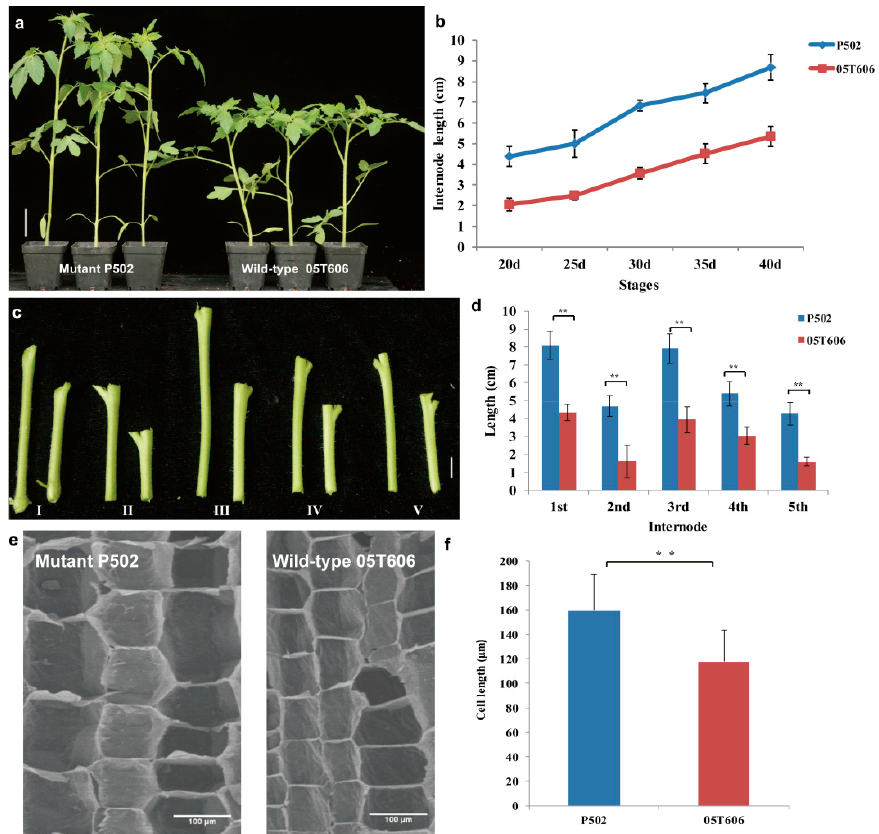
Figure 1. The phenotypic characterization of the mutant P502 and wild-type 05T606 at 40-day-old seedlings. Morphological phenotypes ( a ) and the statistical data of internode lengths ( b ) of the mutant P502 and wild-type 05T606. ( c ) Morphological phenotypes of the first five internode lengths of the mutant P502 (left) and wild-type (right). ( d ) Statistical data of internode length in ( c ). Longitudinal sections ( e ) and the statistical data ( f ) of the third internode pith cell length of P502 and wild-type. Scale bar is 5 cm in ( a ), 1 cm in ( c ), 100 μ m in ( e ). A Student’s t test indicated a significant difference (( b ) and (d), n = 30 plants; ( f ) n = 90 cells) in ( d ) and ( f ). ** p < 0.01. All data are given as mean ± SD.